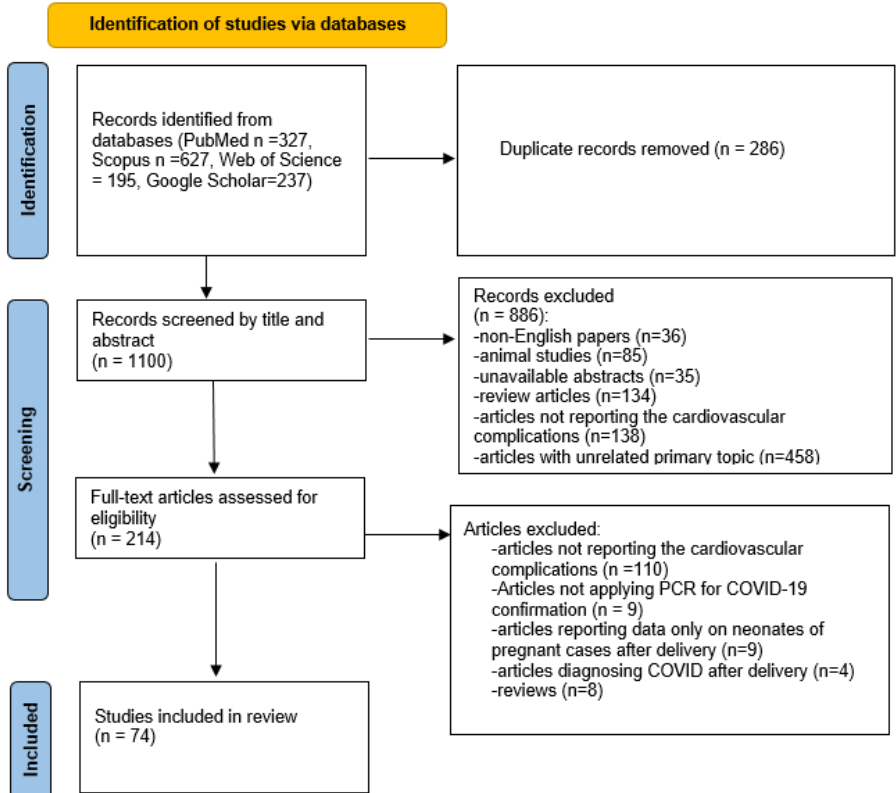
Figure 1. PRISMA flow diagram.